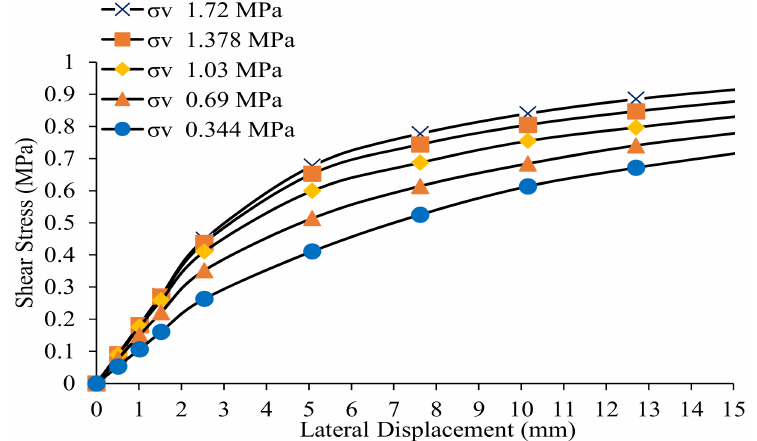
Figure 8. Influence of compressive vertical stress on shear strength of URM walls. Xu and Abrams [3] presented an equation to evaluate the cracking of unreinforced walls due to flexu- ral tensile stress τ = 1 / 6 l/h eff (f t + σ v) where τ is the nominal shear stress between the brick and mortar